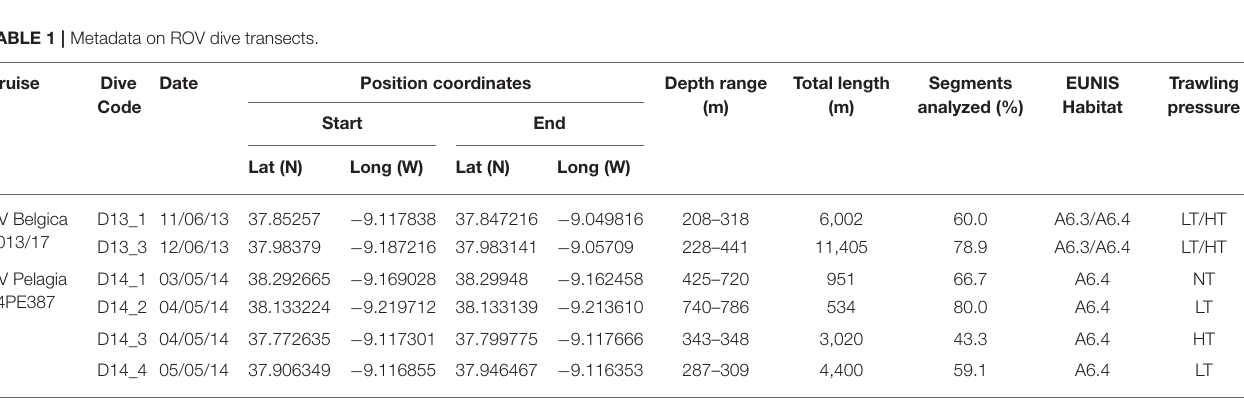
TABLE 1 | Metadata on ROV dive